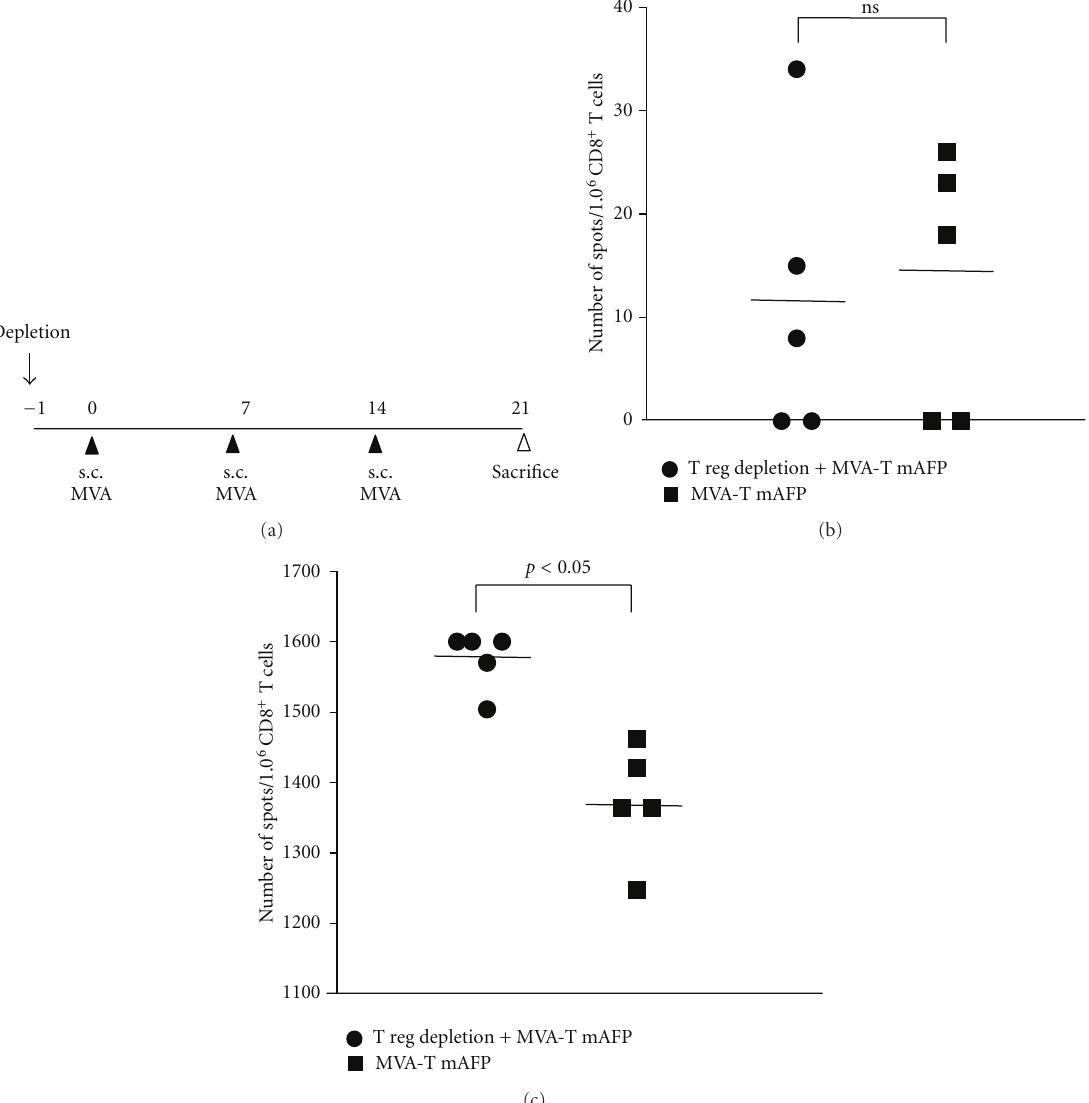
Figure 3: E ff ect of T reg depletion on AFP-specific and MVA-specific CD8 + T-cell immune response. (a) Schematic of the experimental design. (b) AFP-specific CD8 + T cells from MVA-T mAFP vaccinated mice in combination with T reg depletion ( (cid:2) ) or not ( (cid:4) ) were measured by IFNg ELISpot assay. (c) MVA-specific CD8 + T cells from MVA-T mAFP vaccinated mice in combination with T reg depletion ( (cid:2) ) or not ( (cid:4) ) were measured by IFNg ELISpot assay after in vitro stimulation with the MVA-null vector. Statistical analyses were performed by the Mann-Whitney